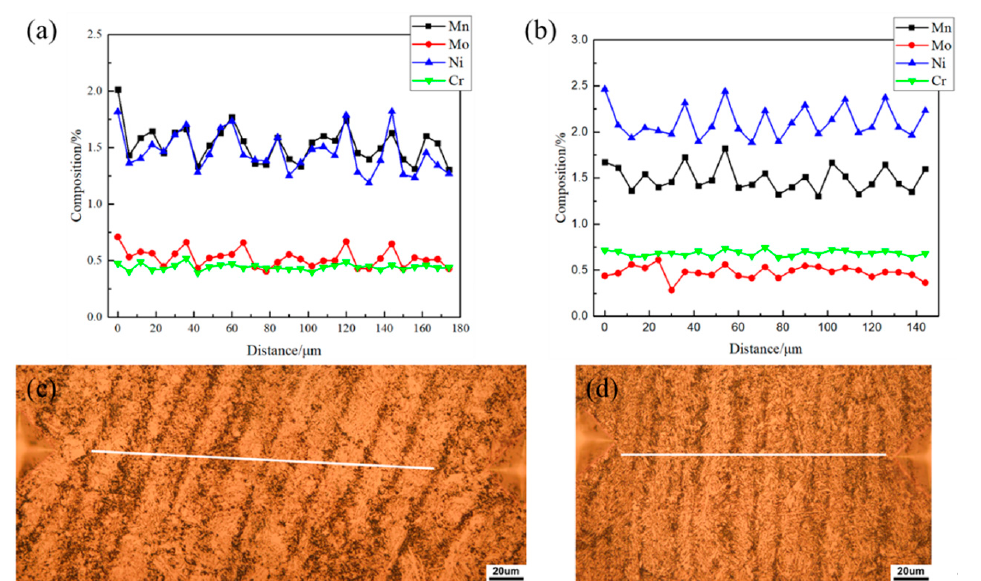
Figure 9. EPMA line scan of weld metal: ( a ) and ( c ) TIG; ( b ) and ( d ) SAW .